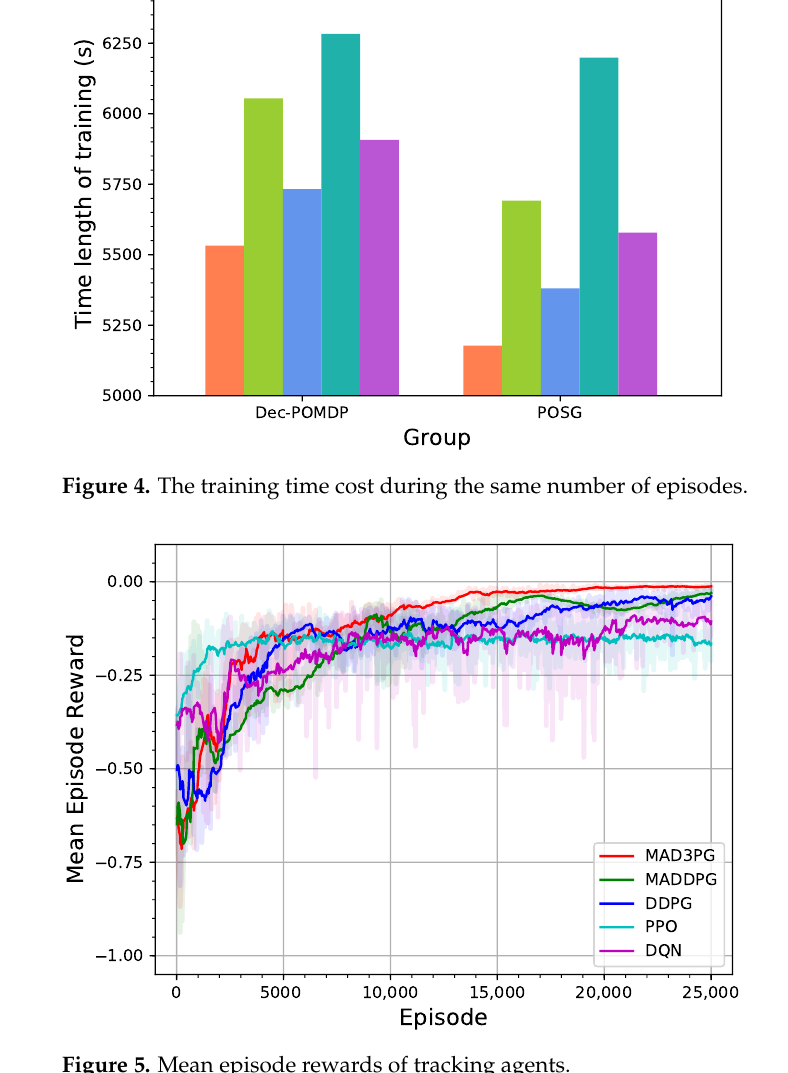
Figure 5. Mean episode rewards of tracking agents. We tested the models of the tracking system at different episodes saved in the training process with the MAD3PG algorithm. The tracking trajectories at the episodes of n ( n ∈ { 1 k , 5 k , 10 k , 15 k , 20 k , 25 k } ) are shown in Figure 6. In these figures, red lines represent the trajectories of the target. At the 1 k -th episode, agents do not know how to follow the target. During the 1 k -th episode to 20 k -th episode, agents gradually have the trend of convergence to the target. Finally, the agents can achieve the learning goal. In general, with the increase of the training episodes, tracking agents gradually learn to track the